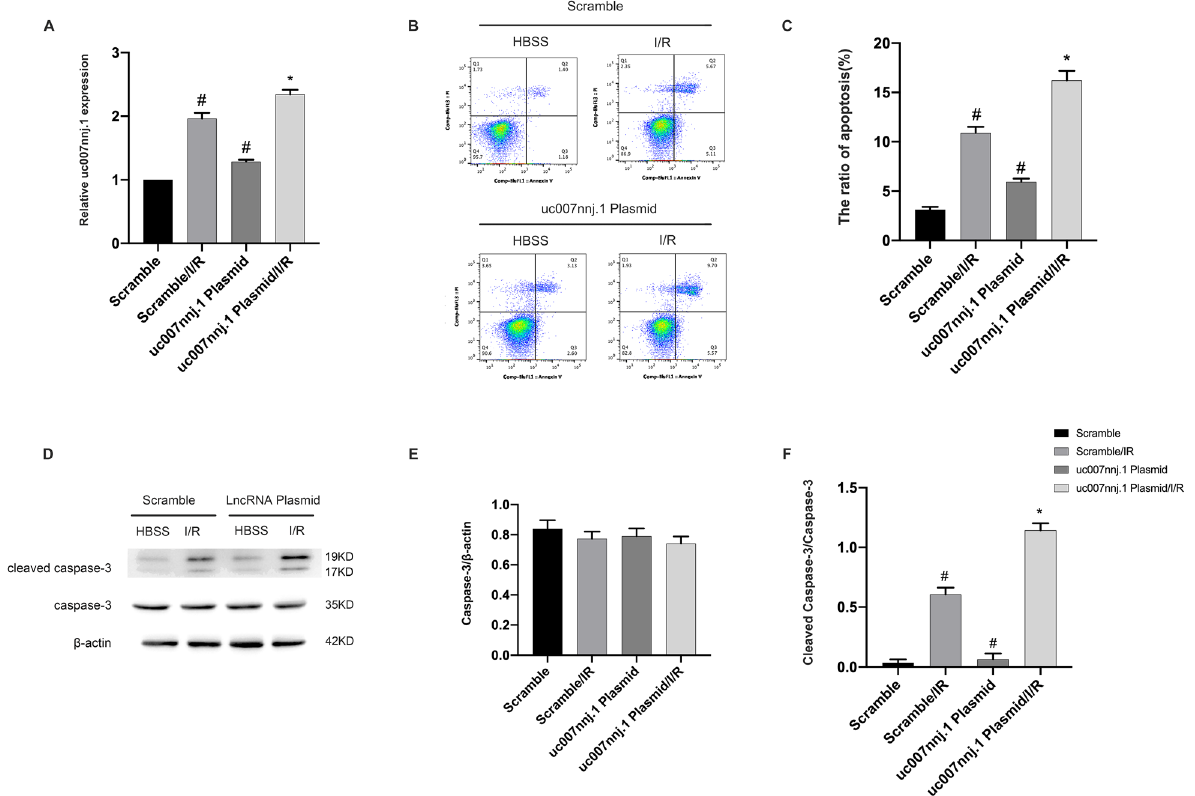
Fig. 3 Overexpression of lncRNA uc007nnj.1 aggravated ischemia-induced neuronal apoptosis. RGCs were transfected with 1 g/mL lncRNA uc007nnj.1 plasmid or scramble and then treated with or without I/R. A RT-qPCR analysis of lncRNA uc007nnj.1 expression. B , C Representative data from the flow cytometric analysis of total cell apoptosis. The Q1 region represents necrotic cells, the Q2 region represents late apoptotic cells, the Q3 region represents early apoptotic cells, and the Q4 region represents normal cells. D Representative image showing a Western blot of caspase-3 and cleaved caspases-3. E , F Quantitative analysis of immunoreactive bands of caspase-3 ( E ) and cleaved caspase-3 ( F ). Data are expressed as mean SD (n 6). # p < 0.05, scramble with I/R group or lncRNA uc007nnj.1 plasmid group versus scramble group; * p < 0.05, lncRNA uc007nnj.1 ± = plasmid with I/R group versus scramble with I/R